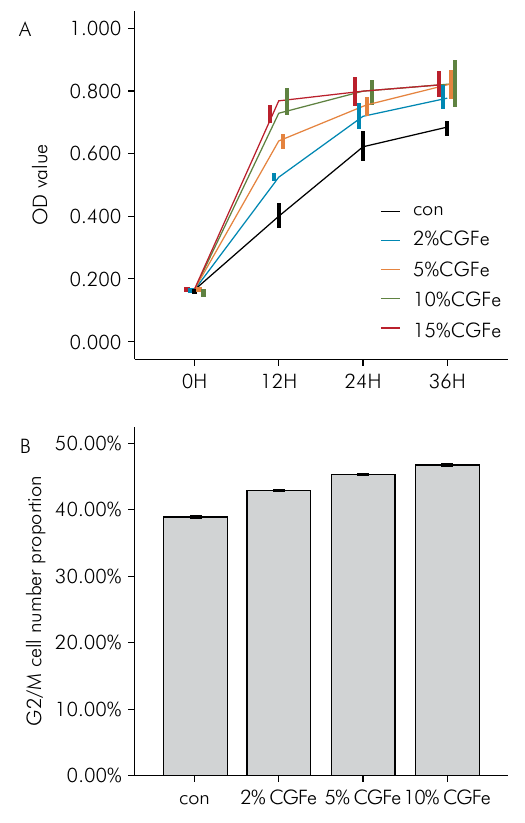
Figure 1. Effects of CGFe on cell proliferation in DPCs. (A) CGFe significantly promoted DPC proliferation in a dose- dependent manner at concentrations ≤ 10% (p < 0.05). However, 15% CGFe showed no difference in promoting effects compared with 10% CGFe (p >0.05). (B) Effect of CGFe on the cell cycle of DPCs. CGFe played a positive role in promoting cell proliferation. All data are presented as the mean ± SE of three independent experiments.